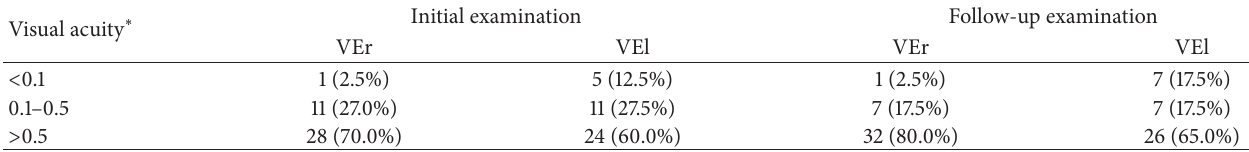
Table 3: Behcet’s disease, visual acuity (quotient percentage of efficiency) of patients with ocular involvement ( 𝑁 = 40 ).